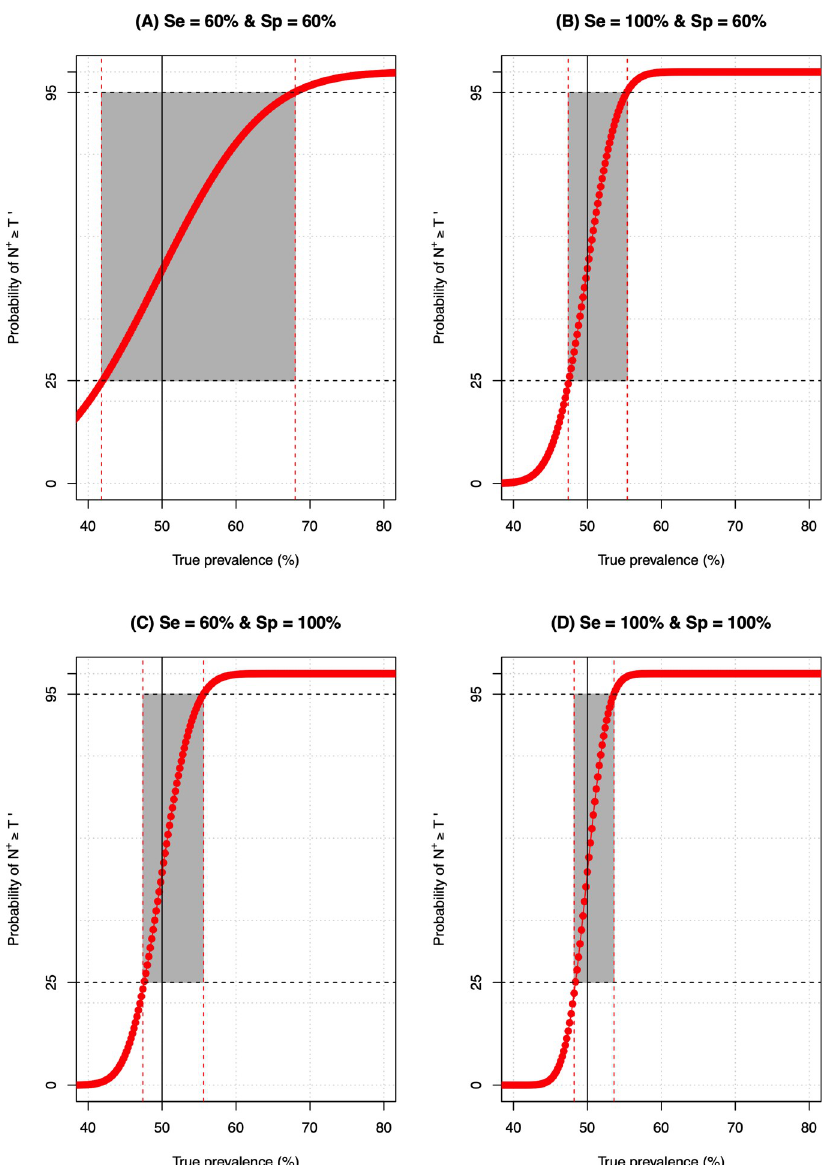
Fig 4. The program decision making around the 50% threshold for four theoretic diagnostic tests. The red line represents provides the probability (in %) of the number of positive test results ( N + ) in a random sample of N subjects (= 500) being at least T 0 (see Eq 3 ) using four theoretic distinct diagnostic tests ( D 1 − D 4 ). The diagnostic tests D 1 − D 3 are imperfect diagnostic methods ( Panel A : Se d 1 = Sp d 1 = 60% ; Panel B : Se d 2 = 100% and Sp d 2 = 60%; Panel C : Se d 3 = 60% and Sp d 3 = 100%), whereas D 4 is a perfect diagnostic method ( Panel D : Se d 4 = Sp d 4 = 100%). The grey area represents the range of true underlying prevalence for which program decision is inadequate ( ε ε undertreat >